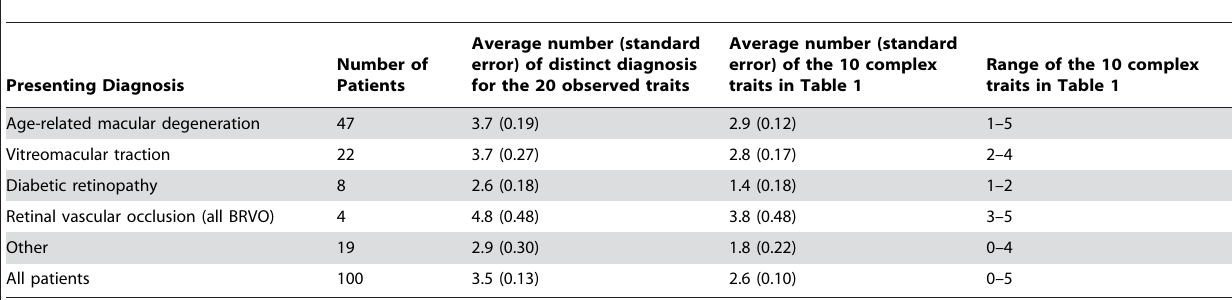
Table 2. Density of complex ocular traits in 100 consecutive patients age 60 or older arranged by presenting diagnosis.